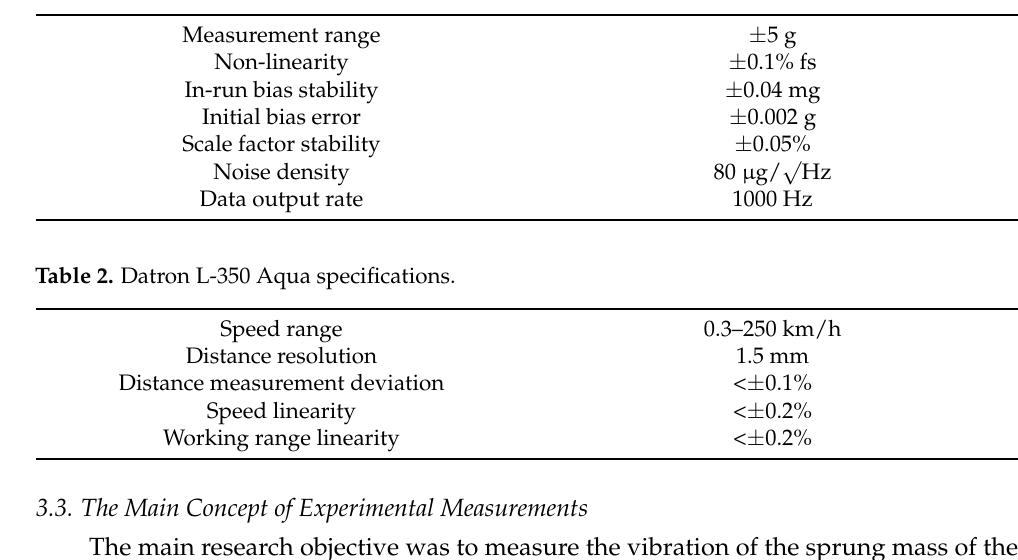
Table 1. Acceleration sensor type 3DM-GX3-25 specifications.